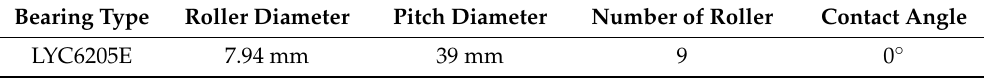
Table 1. The parameters of deep groove ball bearing.